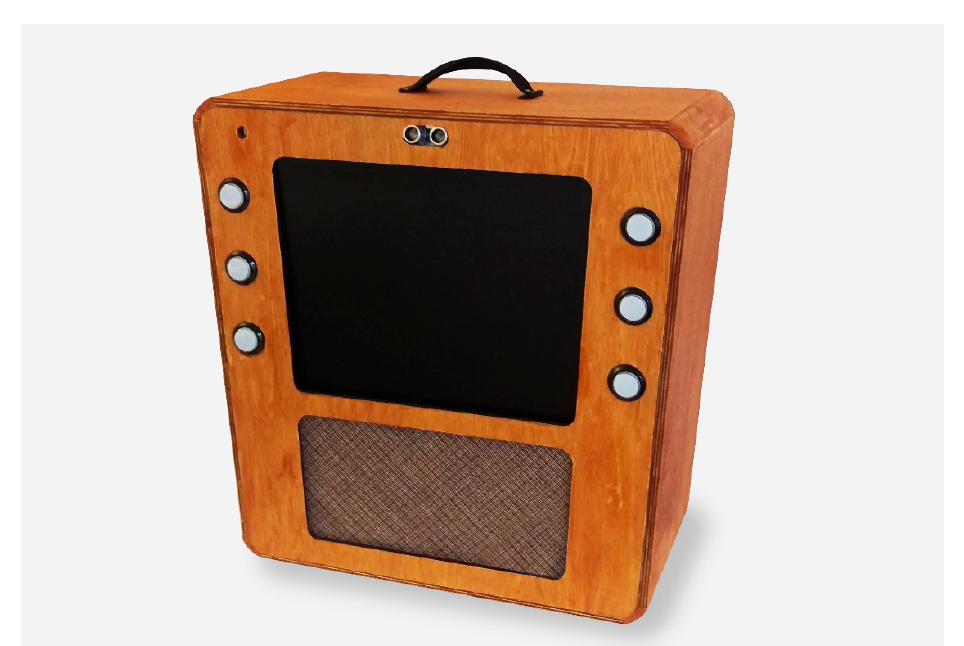
Figure 4. The “Jukebox” prototype.